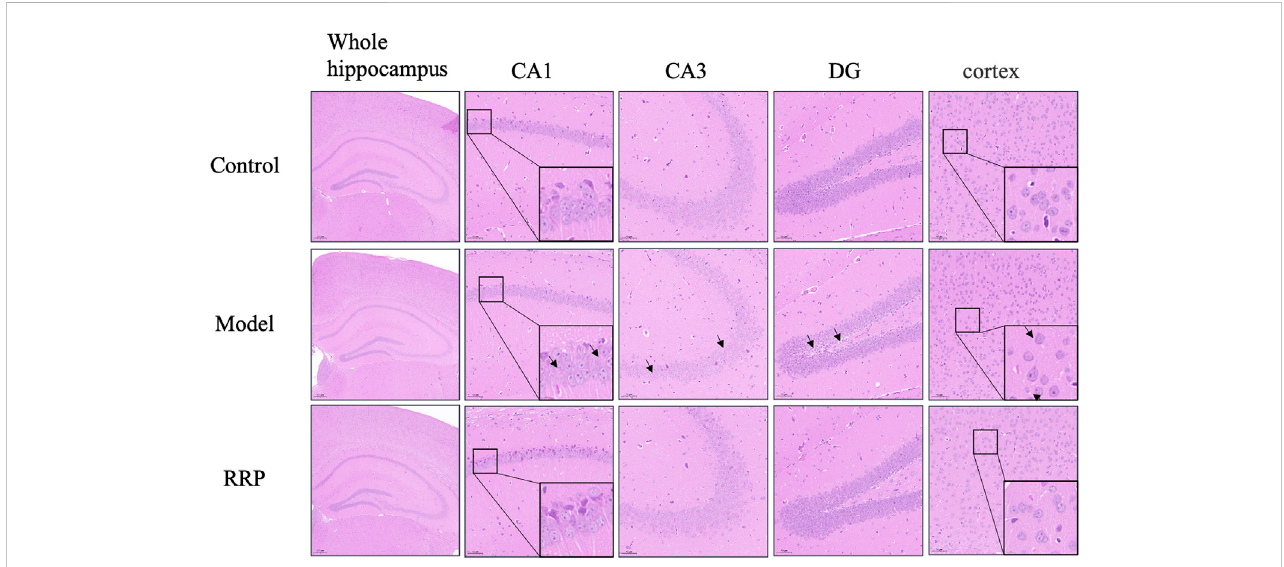
FIGURE 2 H&E staining of brain tissues of mice in each group. Neurons in control group of mice were normal structurally intact, well arranged and with clear nuclear staining. Neuronal cells were loosely arranged with karyopyknosis (as shown by the black arrow) in model group. RRP-treated group showed neatly arranged, evenlydistributedand clearly structured. ( The whole hippocampus isMagni fi cation ×40; CA1, CA3, cortex isMagni fi cation ×200, partial enlarged in CA1 and cortex is Magni fi cation ×1400).